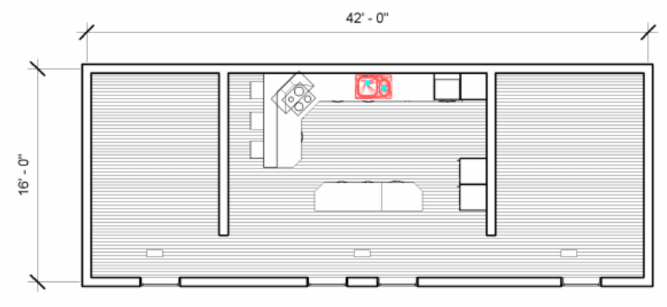
Figure 3. Floor plan of a kitchen space.